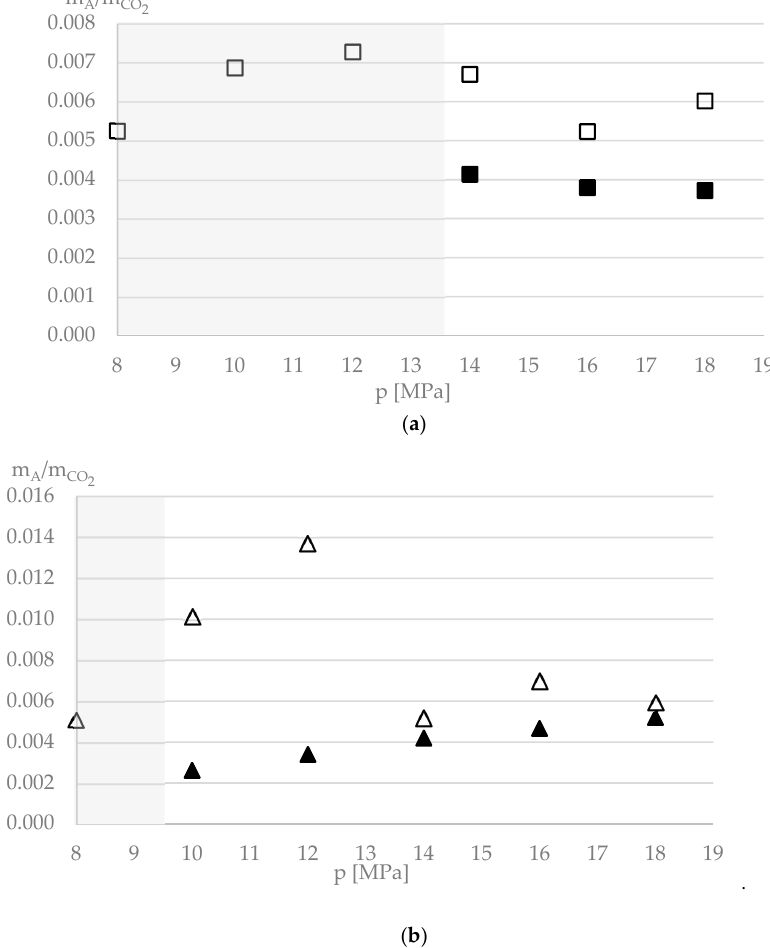
Figure 4. The relative amount of alcohol in the gas phase for the quaternary ■ , (CO 2 + 1,4-BDO + [hmim][B(CN) 4 ] + H 2 O) or ▲ , (CO 2 + 1,2-PDO + [hmim][B(CN) 4 ] + H 2 O) [this work], and binary ♦ , (CO 2 + 1,2-PDO) (Reproduced with permission from [28] Copyright Elsevier, 1998) systems, at 313.2 K.